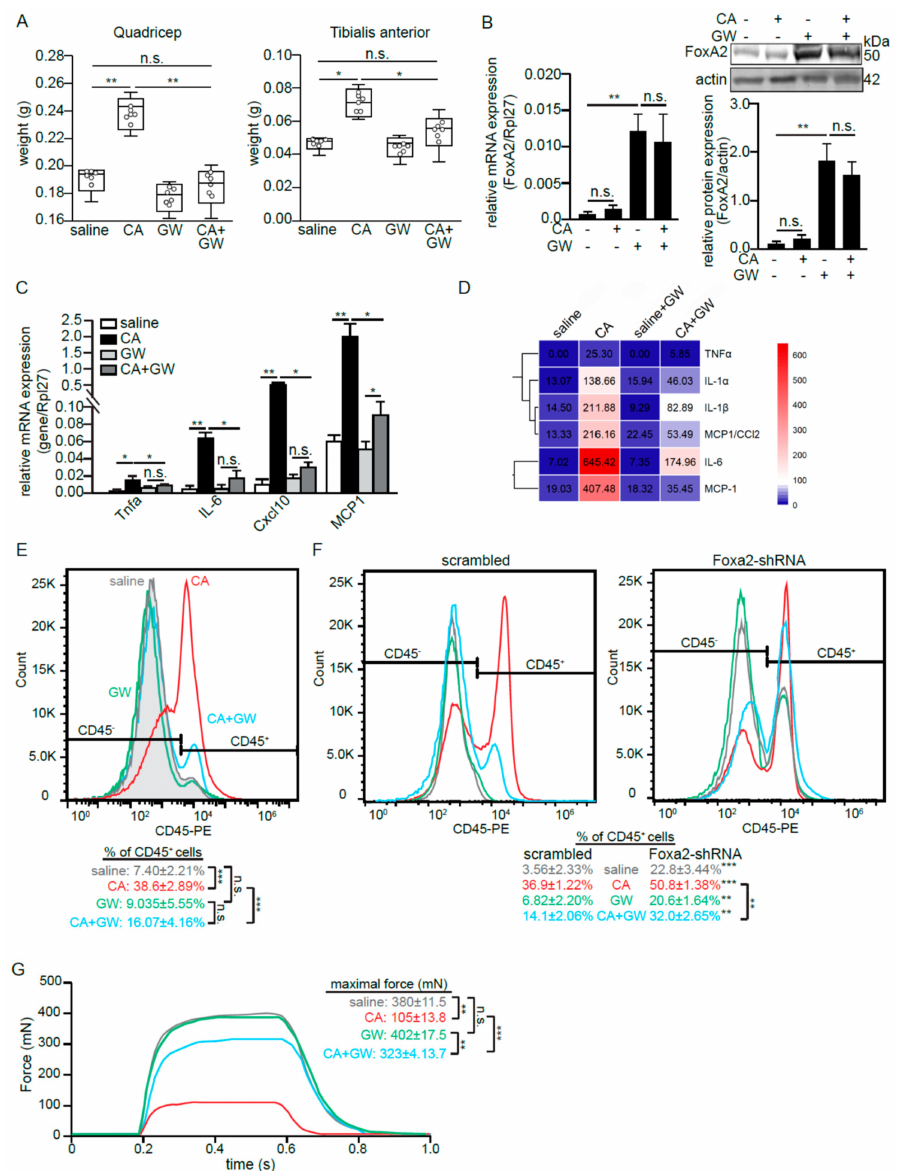
Figure 5. FoxA2 diminishes inflammation-associated muscle damage. ( A ) Mean weight of quadricep and tibialis anterior (TA) muscles at 6 h after saline or CA treatment on contralateral muscles. Hollow circles in the box-and-whiskers boxes represent the individual data points; ( B – D ) Relative FoxA2 ( B ) and pro-inflammatory genes ( C , D ) mRNA (B left panel, C), protein (B right panel, D) expression in TA muscles at 6 h of CA-induced inflammation in the presence or absence of GW501516 (GW). Heatmap showing mean cytokine concentrations from isolated TA muscles; ( E , F ) Representative histogram plots of infiltrated CD45-positive (CD45 + ) immune cells from TA muscle from wildtype mice ( E ), as well as muscle Ad-shFoxA2 and Ad-scrambled mice ( F ) subjected to indicated treatments; ( G ) Mechanical properties of EDL muscle from wild-type mice subjected to indicated treatments. Representative plots show maximal tetanus force recorded. Five mice per experiments are used for each treatment. n = 3 independent studies. * p < 0.05; ** p < 0.01, *** p < 0.001; and n.s., not